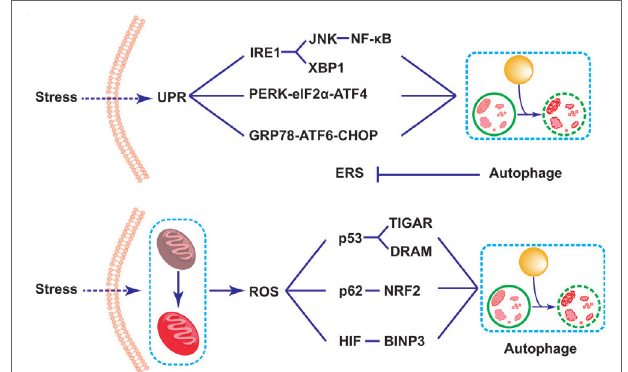
FigURe 2 | Schematic illustration of mechanisms of Paneth cell autophagy related to endoplasmic reticulum stress (ERS) and reactive oxygen species (ROS) in inflammatory bowel disease alleviation. Under the challenge of stresses, the triggering of the self-protected unfolded protein response process leads to the induction of ERS in Paneth cells. The ERS subsequently results in the induction of autophagy through three signaling pathways, including IRE1-JNK/NK- κ B/XBP1, pancreatic ER kinase-eIF2d-activated transcription factor 4, and GRP78-activated transcription factor 6-CHOP signaling pathways. The induction of autophagy thus reduces the over- triggering of the ERS. In addition, the mitochondrial dysfunction triggers the accumulation of the reactive oxygen species (ROS) in Paneth cells. The triggering ROS largely induces autophagy process through the p53-TIGAR/ damage-regulated autophagy modulator, p62-NF-E2-related factor 2, as well as BINP3 pathways, thus fighting against cellular damage under stresses.